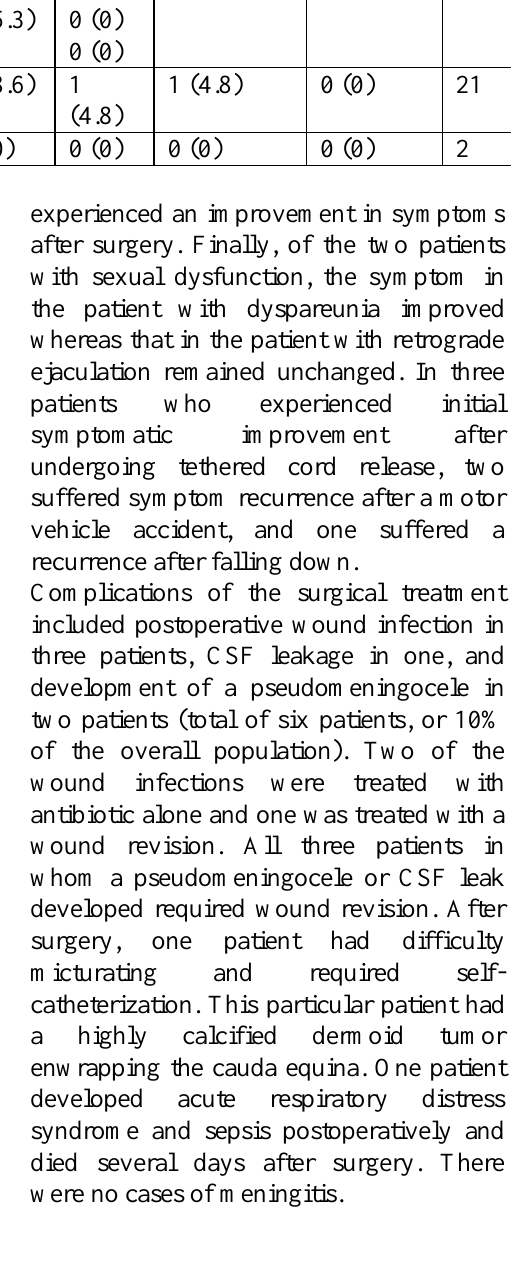
Table 1. Surgical outcomes in adult patients after tethered cord release stratified by presenting signs and symptoms Signs and